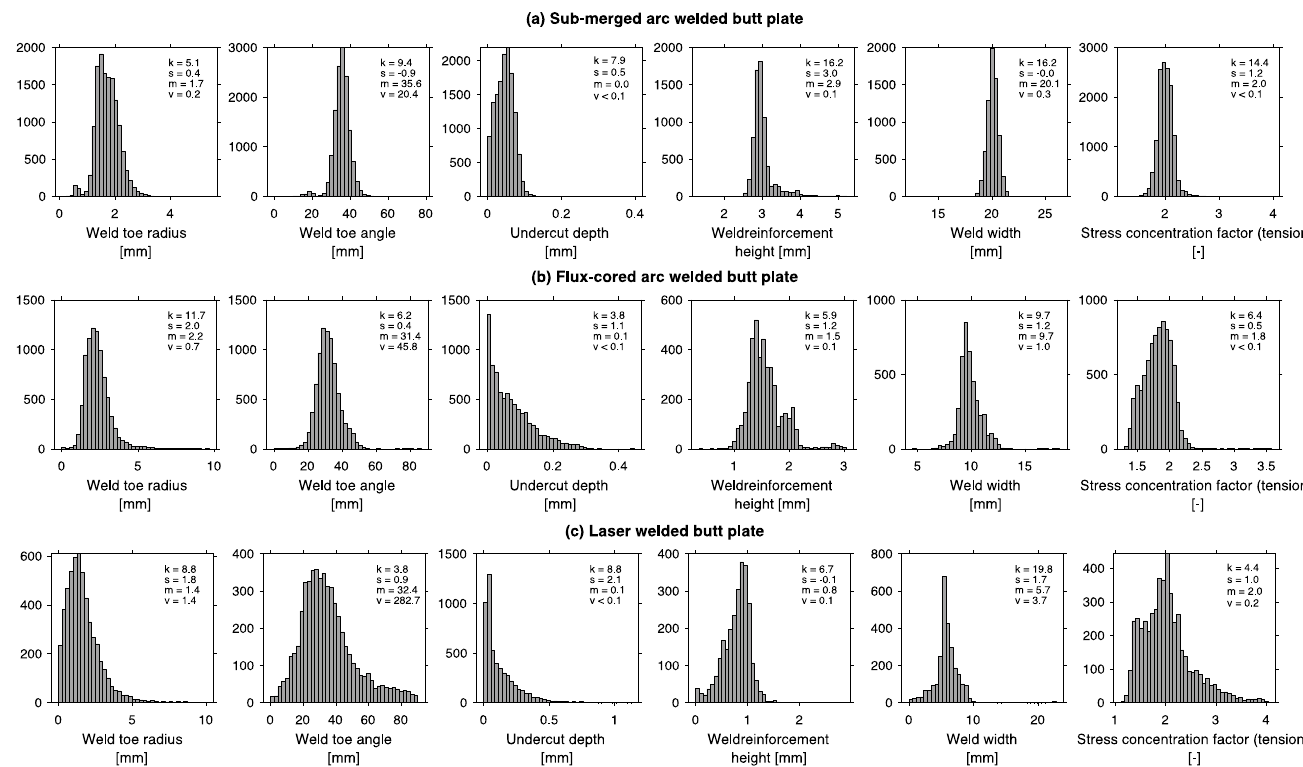
Figure 9. Exemplary histograms of various important geometrical parameters that describe weld geometries obtained from assessing weld seam sections about 1 m long.